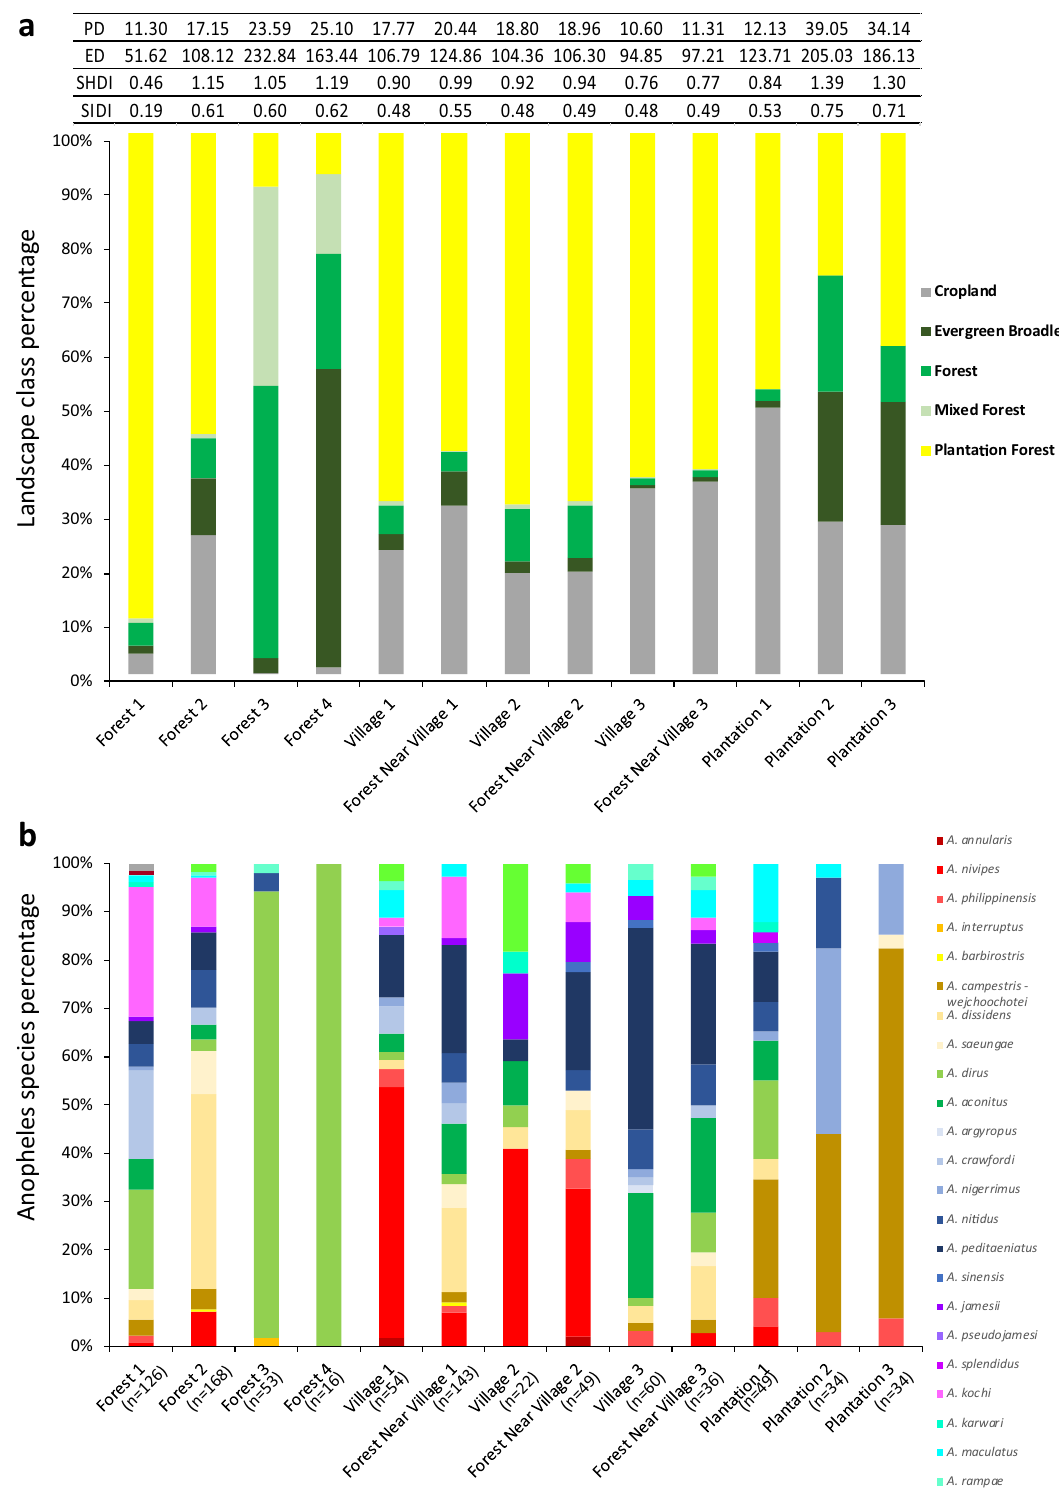
Figure 8. ( a ) Percentage of each land cover category per collection site determined by a 2 km buffer zone and based on Landsat imagery (Landsat 4–8, 30 m resolution, 2017). Land cover classes defined as: cropland (land with herbaceaous and shrubby crops with harvesting and bare soil periods), evergreen broadleaf (land dominated by trees > 60% canopy cover with a tree above 5 m, evergreen broadleaf trees make up > 60% of the total tree cover), forest (land spanning more than 0.5 hectares with trees higher than 5 m and a canopy cover of more than 10%), mixed forests (land with > 60% tree canopy cover, tree height is greater than 5 m, and the forest composition is mixed such that no single forest type makes up > 60% of the total tree cover), plantation forests (land cultivated with perennial crops that reach heights above 5 m and occupy the land for long periods). The table is indicating patch density (PD), edge density (ED), Shannon’s diversity index (SHDI), and Simpson’s diversity index (SIDI) for each buffer zone. ( b ) Percentage of each mosquito species (molecular identification) sampled in each collection site. Sample sizes are given in